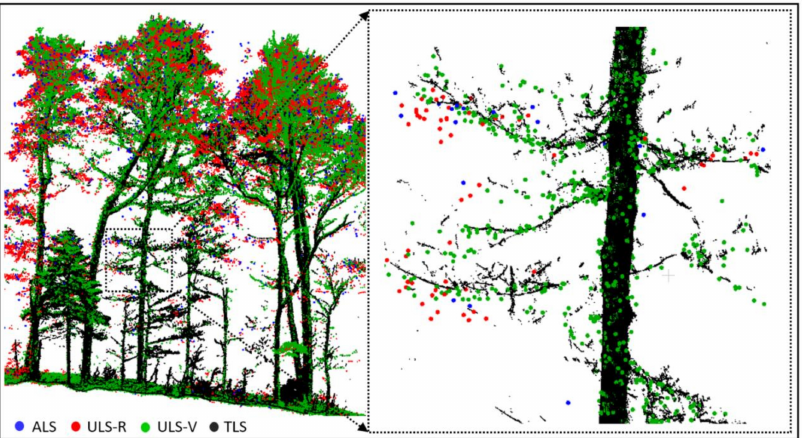
Figure 6. Co-registration of the ALS, ULS-R, ULS-V, and TLS point clouds with a zoom at the individual